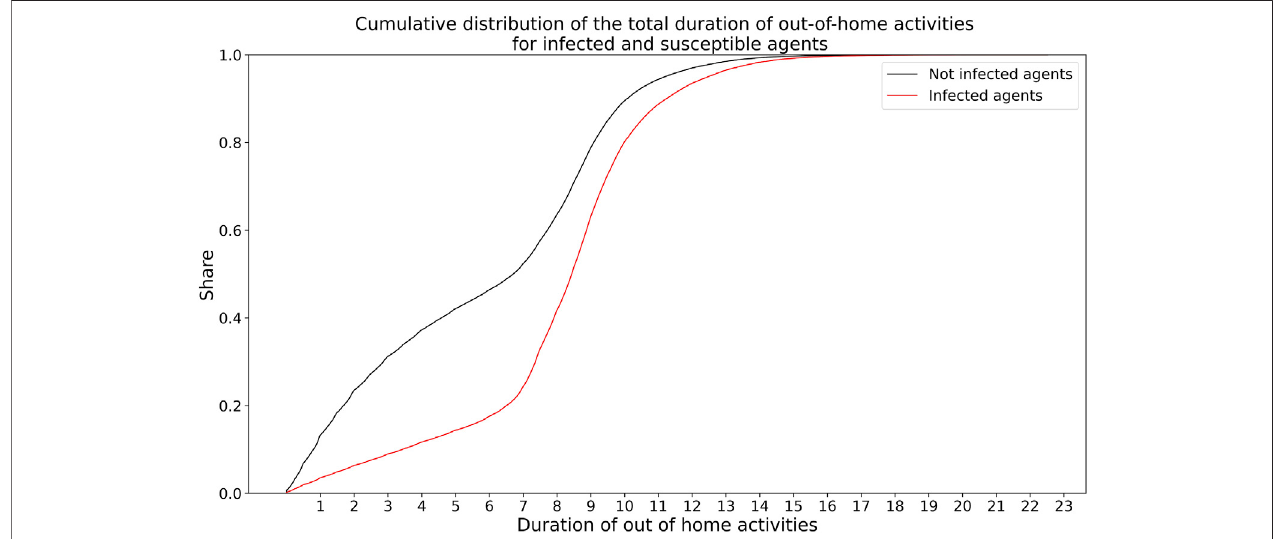
FIGURE 11 | Cumulative distribution of the total duration of out-of-home activities for infected and susceptible agents.